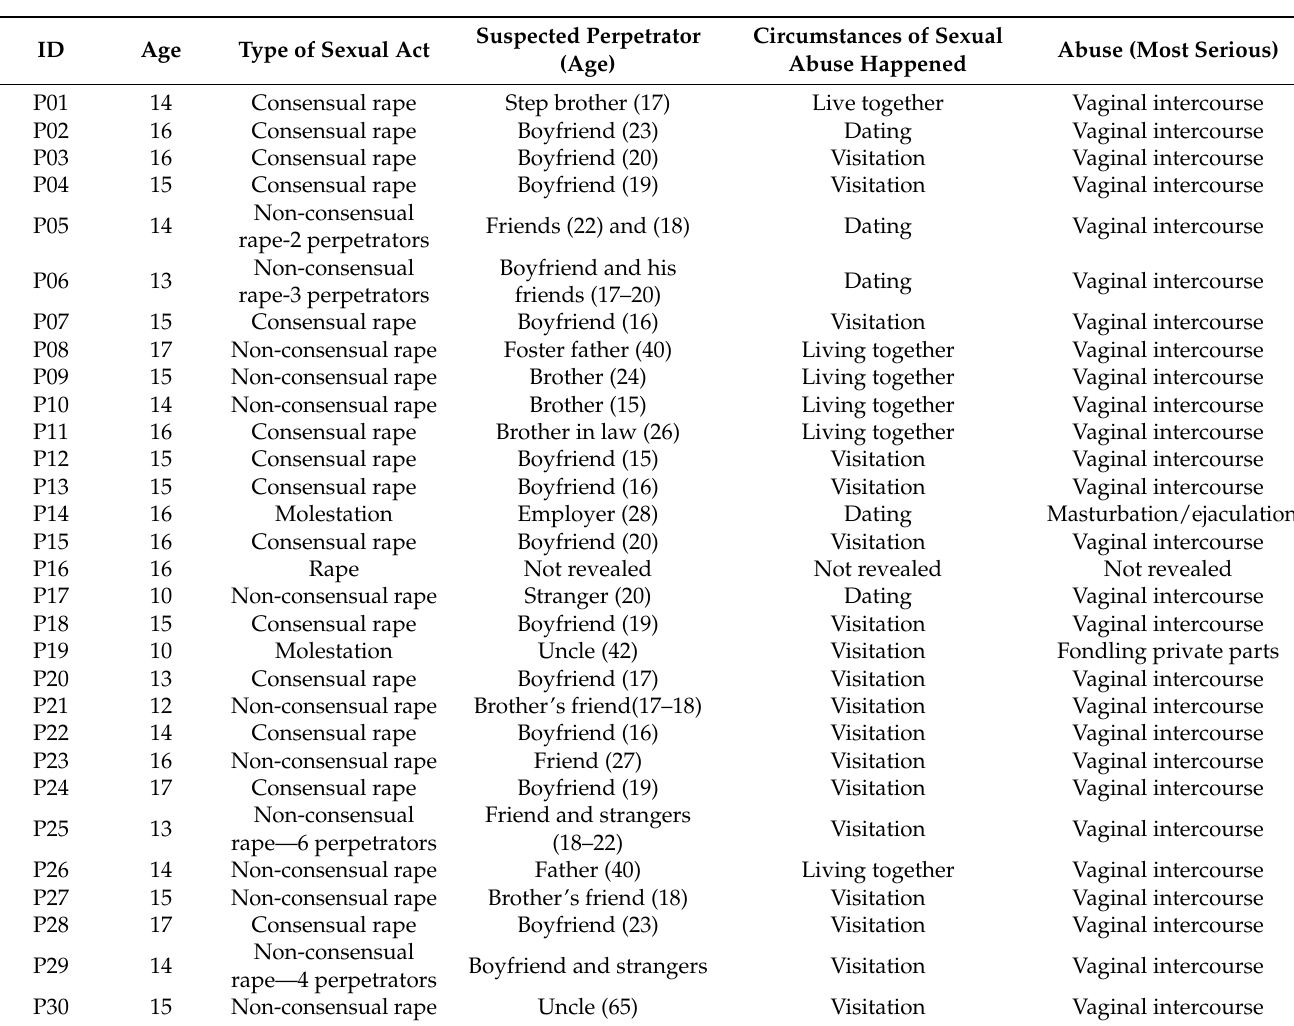
Table 3. Sexual history of the